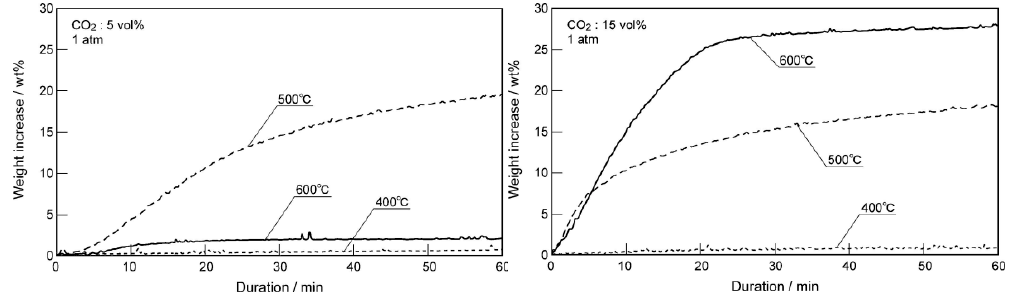
Figure 12. Weight increase of Li 4 SiO 4 at different temperatures in different CO 2 concentrations [77].